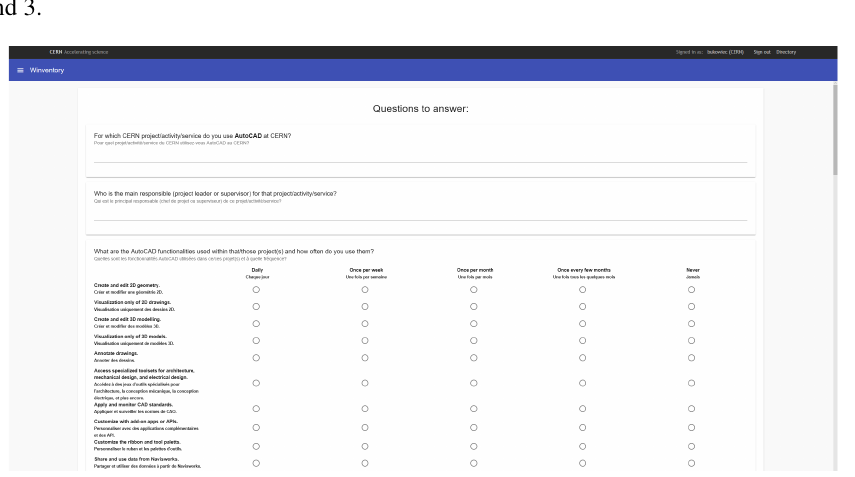
Figure 3. The Winventory application frontend survey